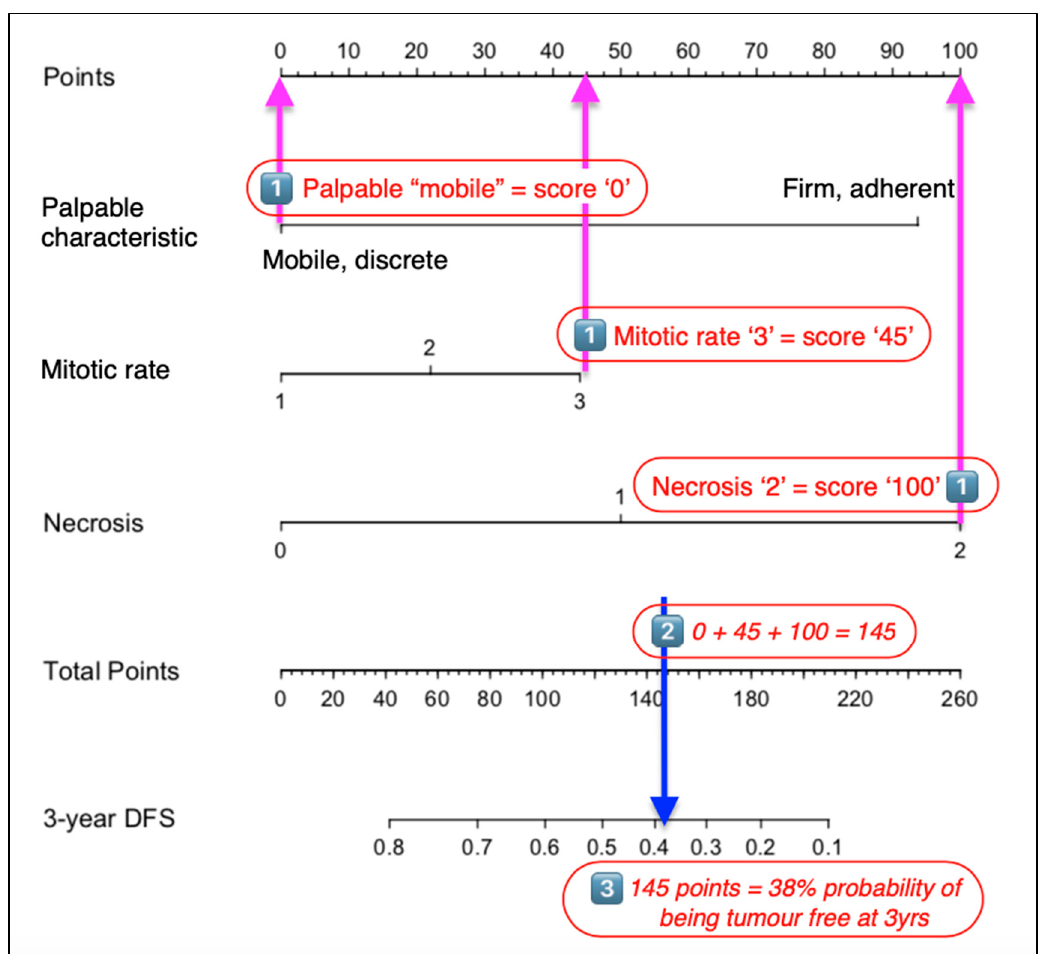
Figure 2. Steps to using a nomogram. (1) Determine the POINTS scored for each characteristic defined in the nomogram. (2) Total these points and identify this value on the TOTAL POINTS scale. (3) The 3-year disease-free interval is then determined using the proportional scale that is in line with the value identified in the previous calculation.